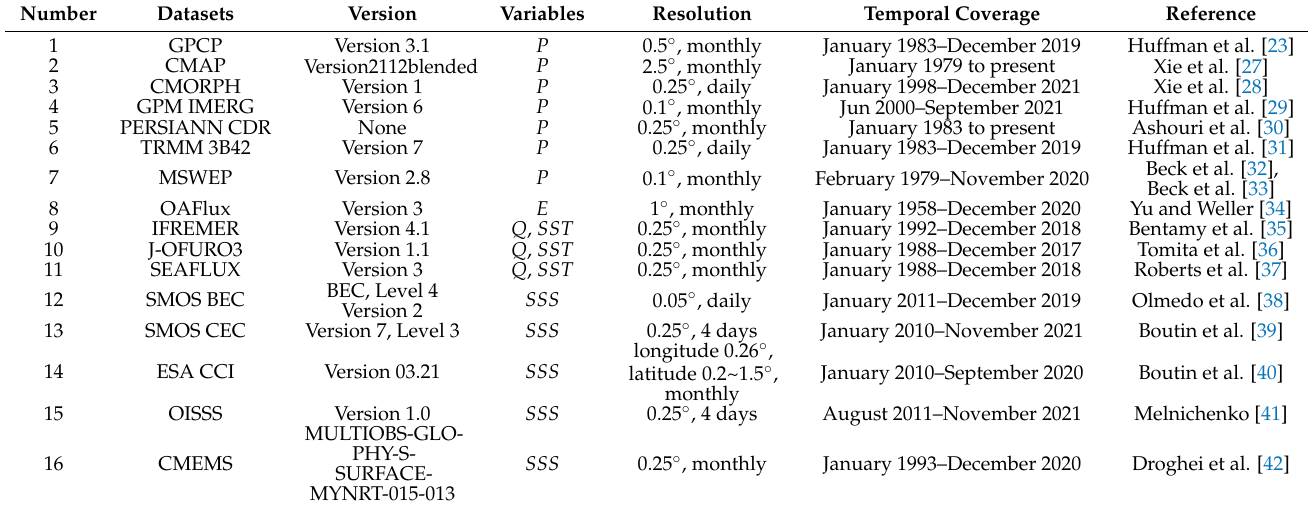
1 Data can be downloaded from links in the data availability section. Some datasets need registration before